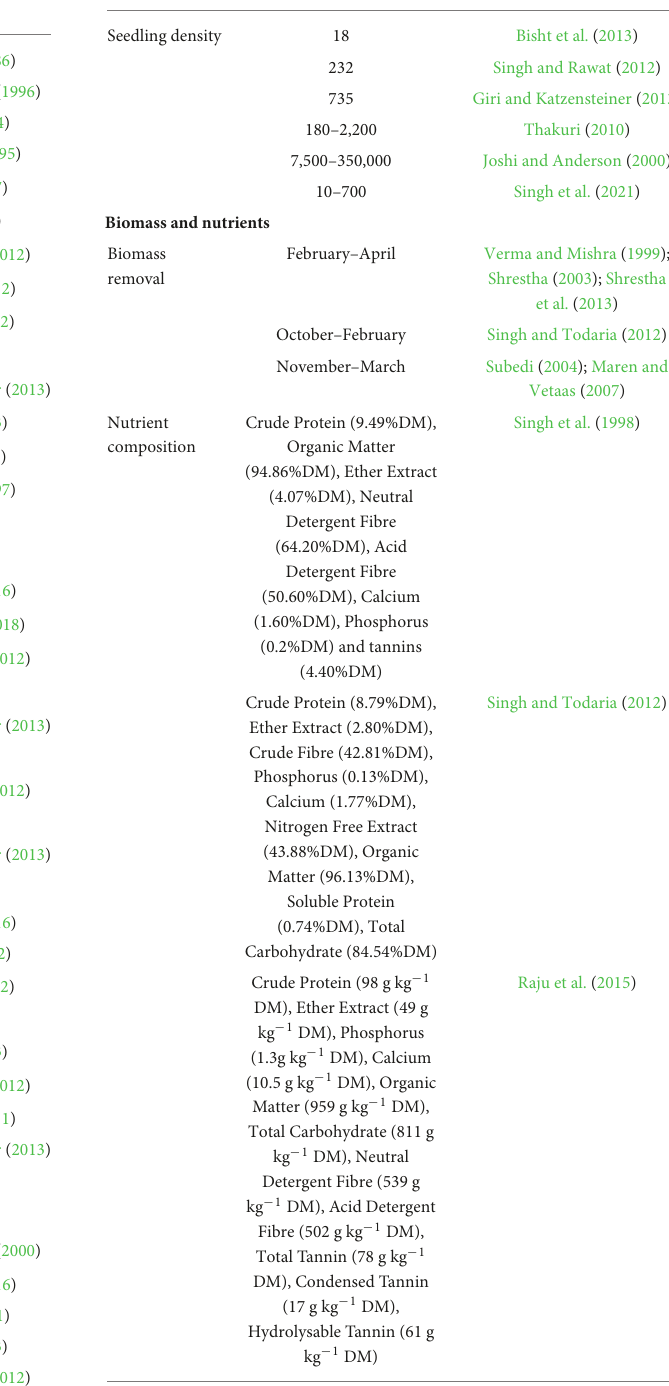
TABLE 3 Details of the quantitative parameters in Q. semecarpifolia